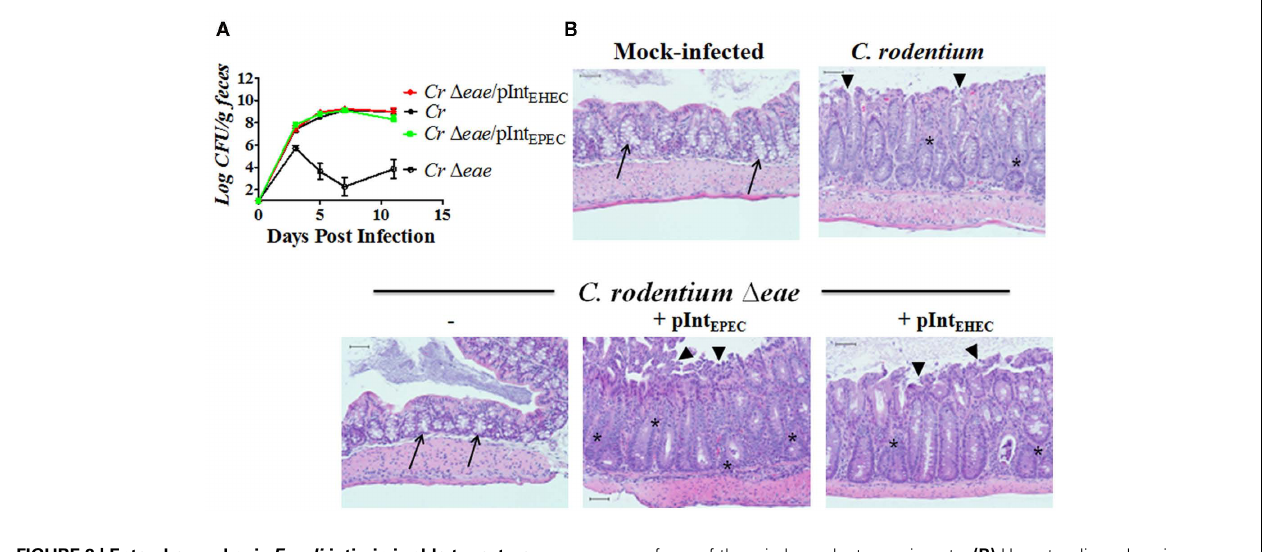
of one of three independent experiments. (B) Hematoxylin and eosin stained large intestinal sections from mock-infected mice or mice infected with indicated strain are shown under 100 × magnification. Arrow heads point to ragged areas of the surface epithelium at sites of surface erosion. Arrows point to areas of many goblet cells. Asterisks indicate areas of active inflammation. Scale bars measure 50 μ